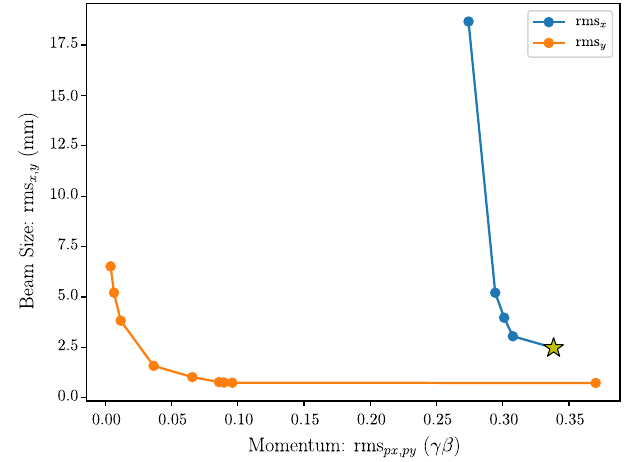
FIG. 9. Pareto front comparing transverse beam sizes (rms and transverse momentum (rms the point plotted in Fig. 10.